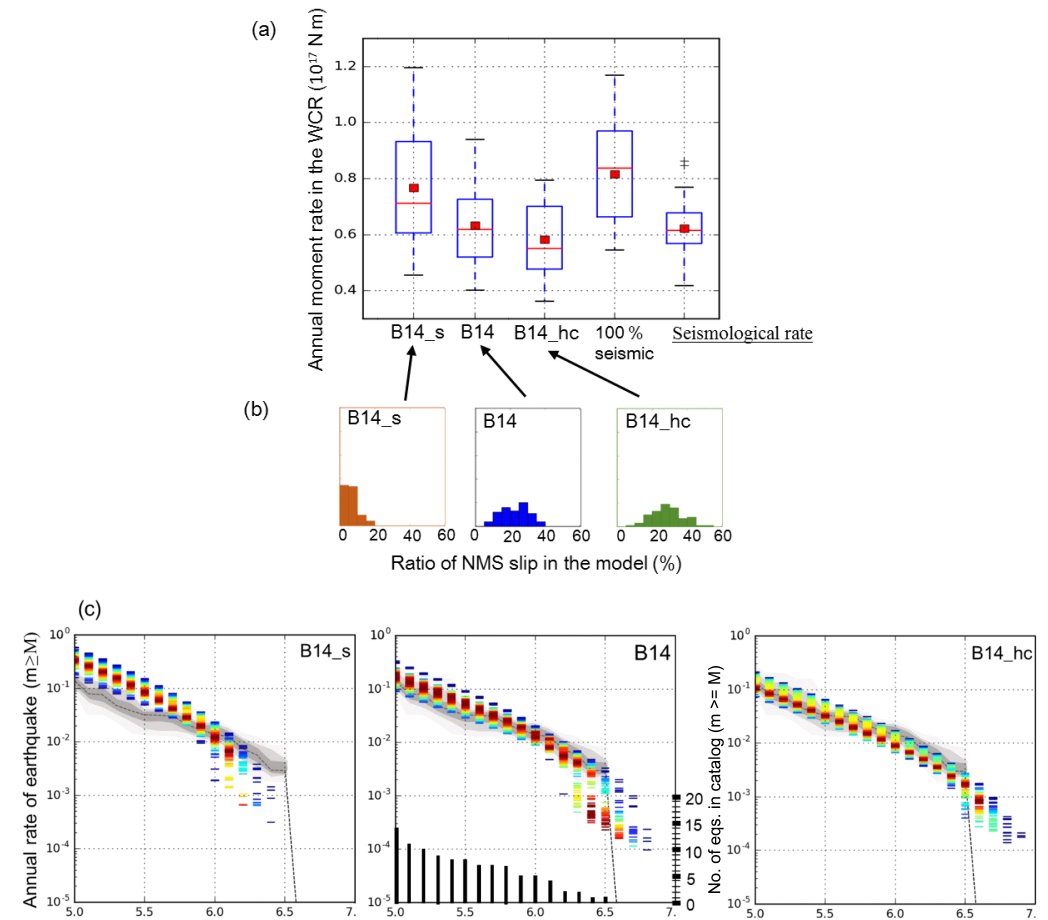
Figure 4. Modeled seismicity for the WCR fault network and comparison to the seismicity rate based on the earthquake catalog of the complete period. (a) Comparison between the modeled moment rates for each FtF scenario set and the seismological rate calculated from the earthquake catalog. Each box represents the SD around a mean and median value represented by a red square and a red line respectively. From left to right: the three first boxes are for each hypothesis scenario set in the logic tree, the fourth box shows the moment rate assuming 100% of the slip rate of faults is converted into seismic moment, and the fifth box shows the moment rate calculated from the earthquake catalog. (b) Distribution of the ratio of NMS slip resulting from the three deformation models. (c) Comparison between the modeled GR MFD deduced from geological data for the whole fault system and that deduced from the WCR catalog. The models are represented as a colored density function with the red colors for the rates predicted by the higher number of models. The cumulative rates calculated from the catalog are shown as a grey density function. The cumulative number of earthquakes in the catalog is indicated by black bars in the central figure.